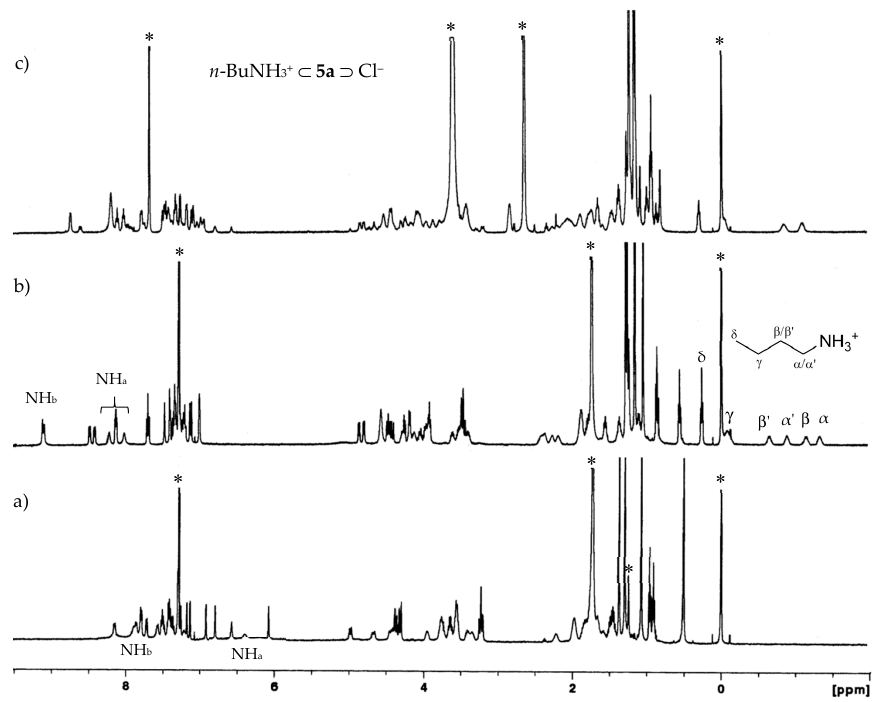
Figure 6. 1 H-NMR spectra (500 MHz) of: ( a ) [ 5a ] = 1.0 mM at 253 K in CDCl 3 ; ( b ) [ 5a ] = [ n -BuNH 2 ·HCl] = 1 mM at 253 K in CDCl 3 ; ( c ) [ 5a ] = [ n -BuNH 2 ·HCl] = 1 mM at 243 K in CDCl 3 /DMSO-d 6 , 5:1, v / v . * Denotes residual solvent signals.